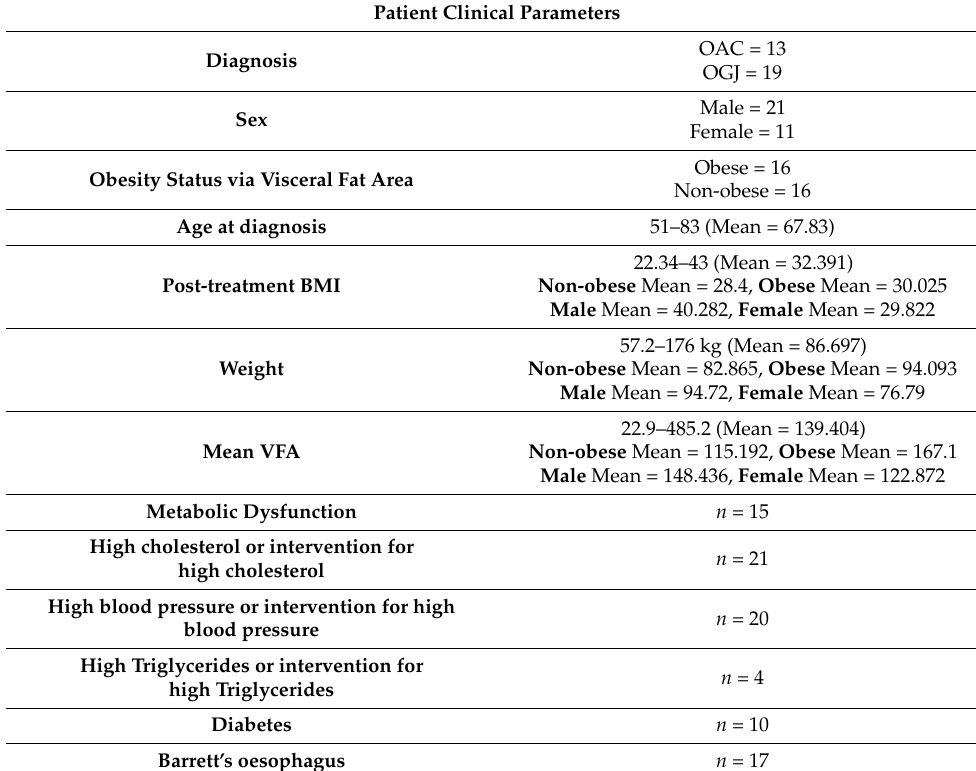
Table 1. All fresh adipose tissues were taken at the start of the surgical tumour resection procedure from OAC or OGJ (oesophagogastric junctional adenocarcinoma) patients being treated with curative intent. Table 1. Clinical demographics of patient